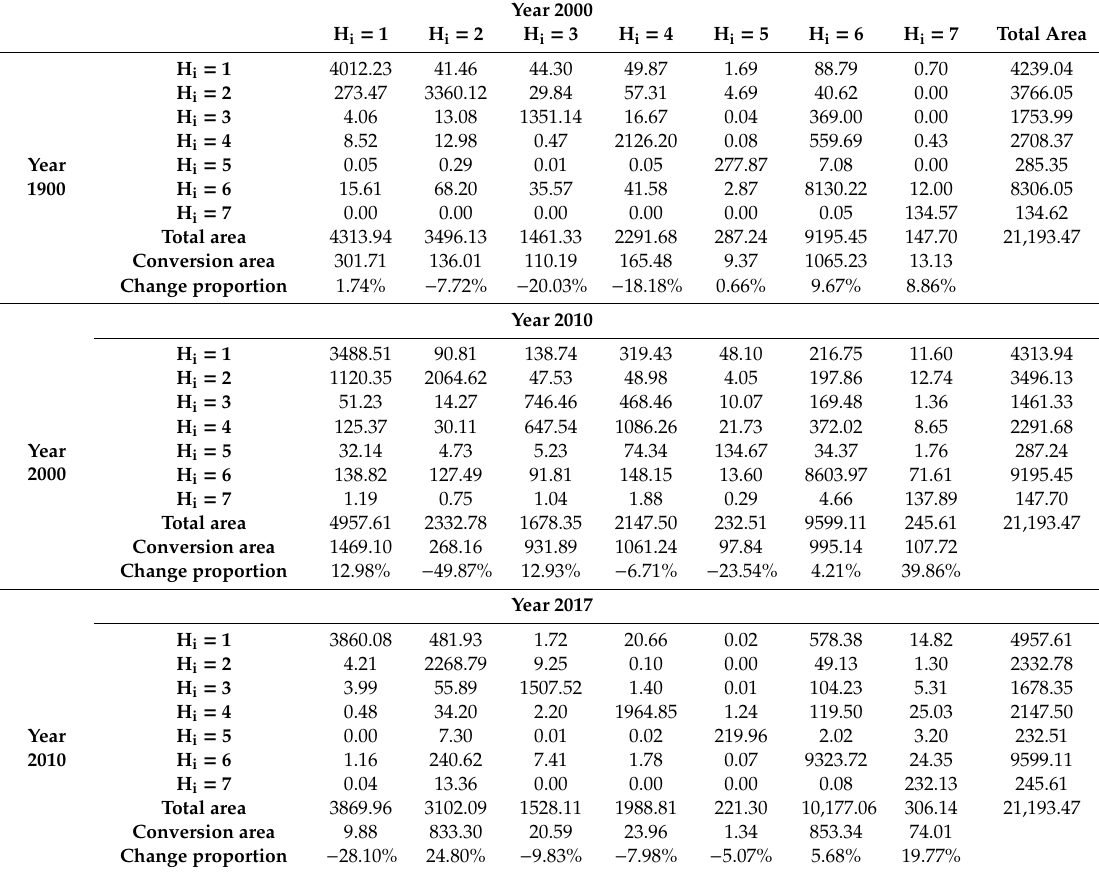
Table 3. Land use conversion values of areas with di ff erent H i for the period 1990-2017 (km 2 ).